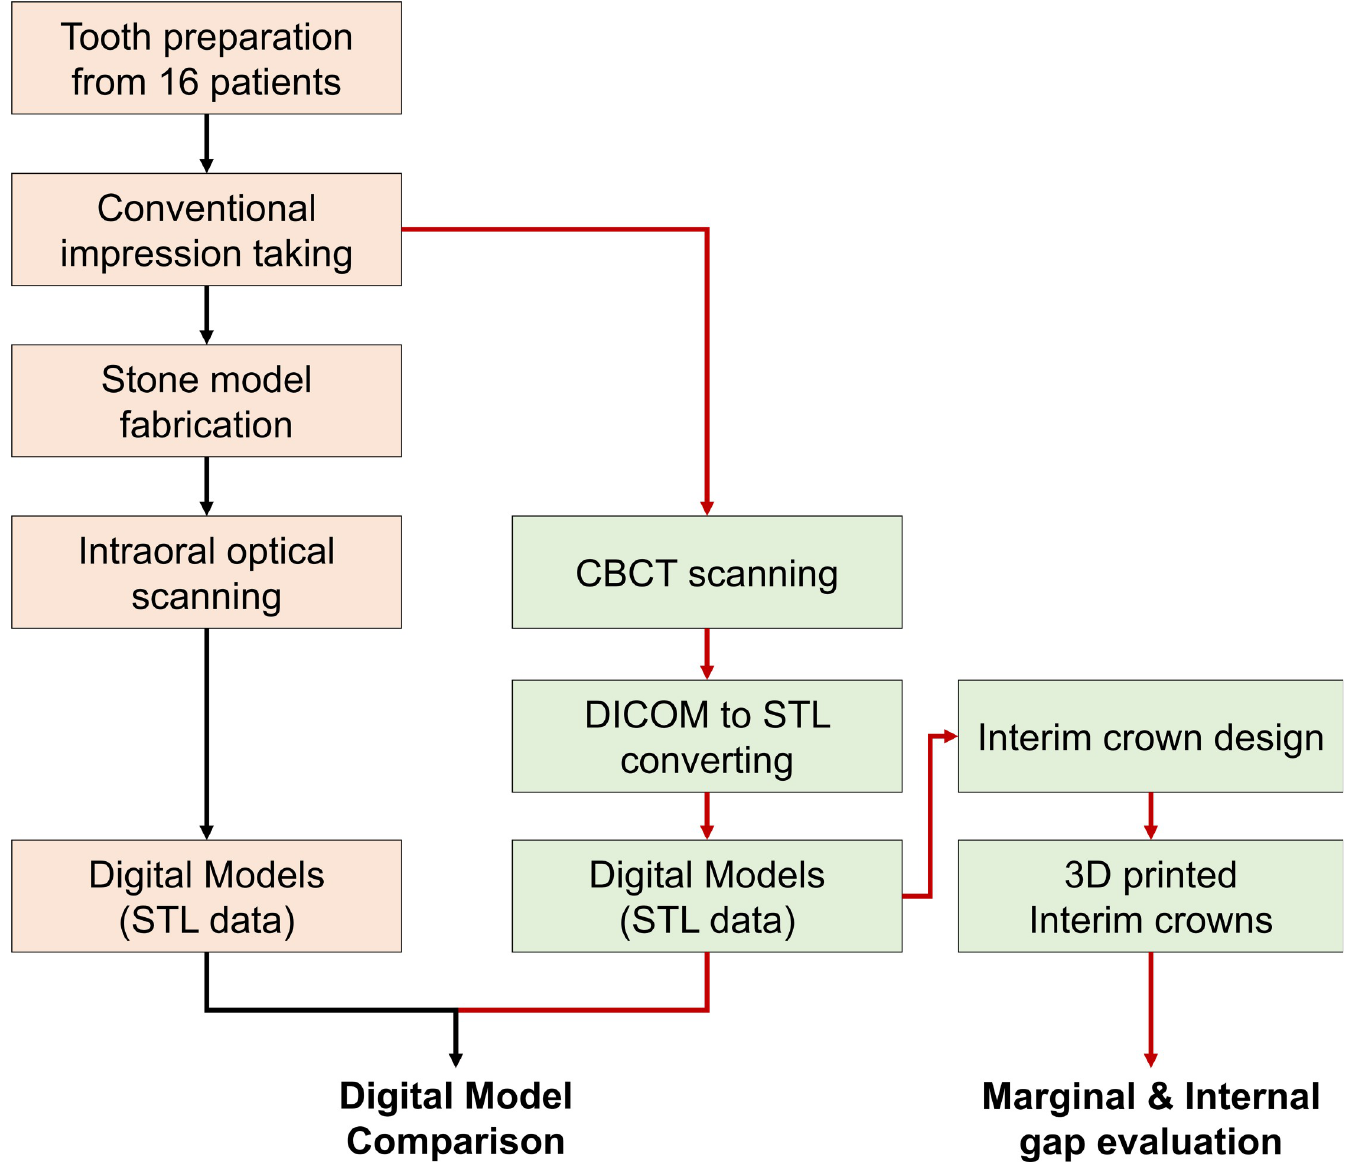
Fig 1. The overall experimental workflow in this study. Two devices were used in this experimental study to obtain digital models: an intraoral scanner (black line) and CBCT (red line).